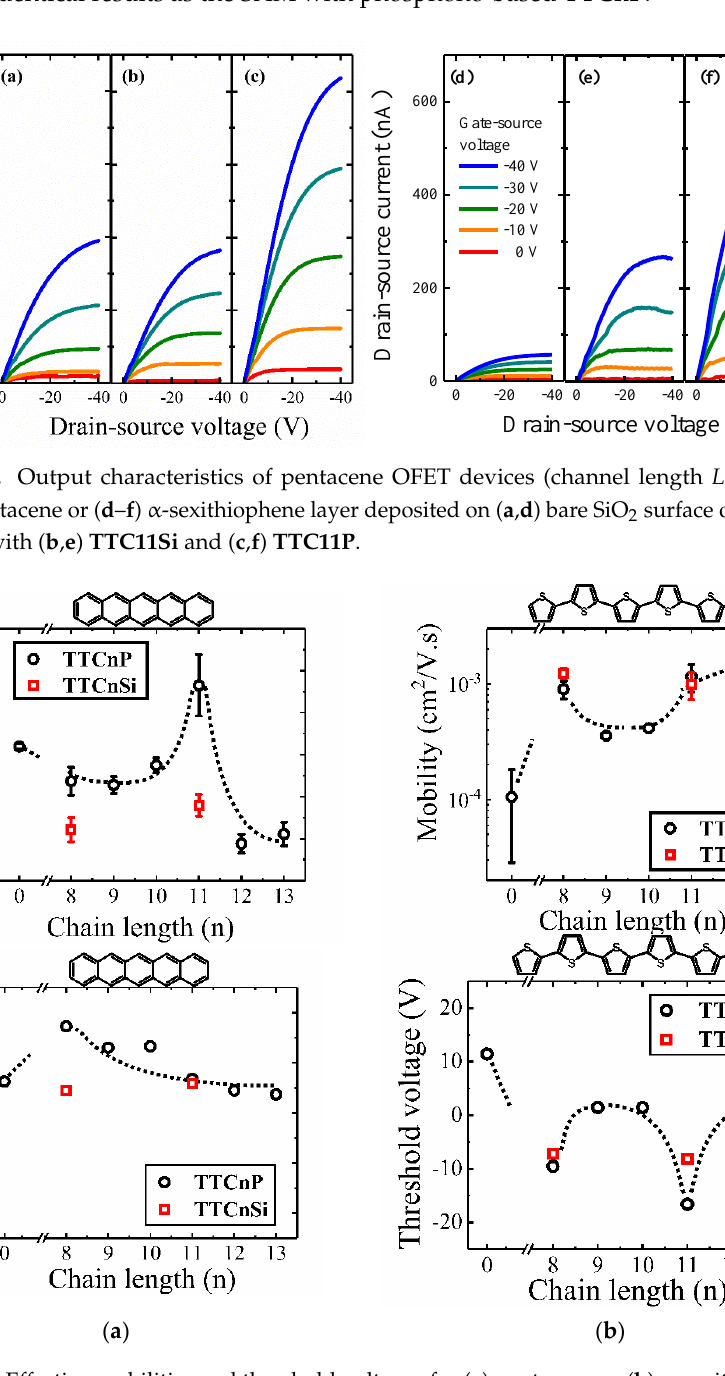
Figure 5. Effective mobilities and threshold voltages for ( a ) pentacene or ( b ) α -sexithiophene OFETs using bare and SAM-modified substrates.